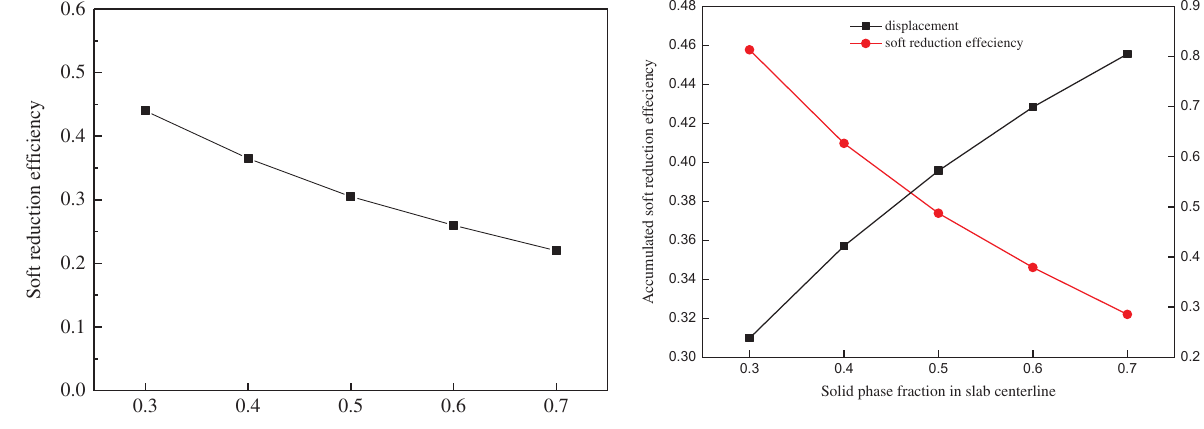
Figure 12: Relationship between the calculated accumulated displacement of solidification front and soft reduction efficiency and solid